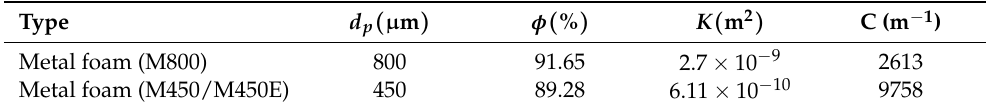
Table 2. The properties of porous materials employed for the poro-serrated